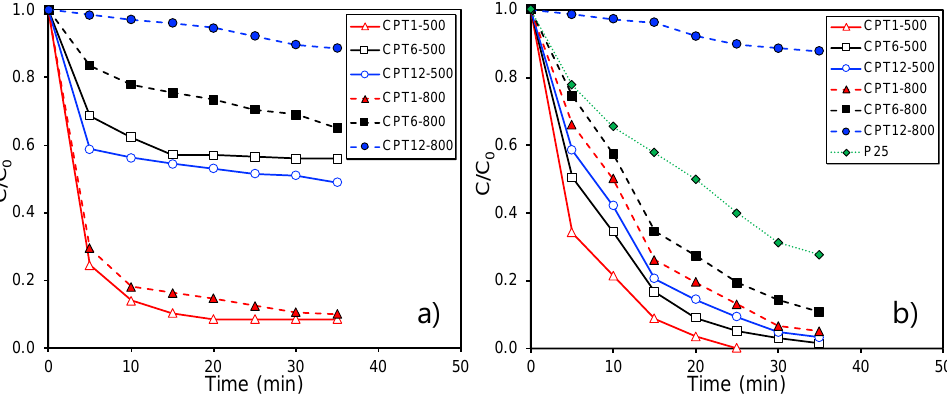
Figure 5. Removal of the Orange-G from water solution by adsorption ( a ) and photocatalytic ( b ) processes using carbon-phosphorus-Ti composites.